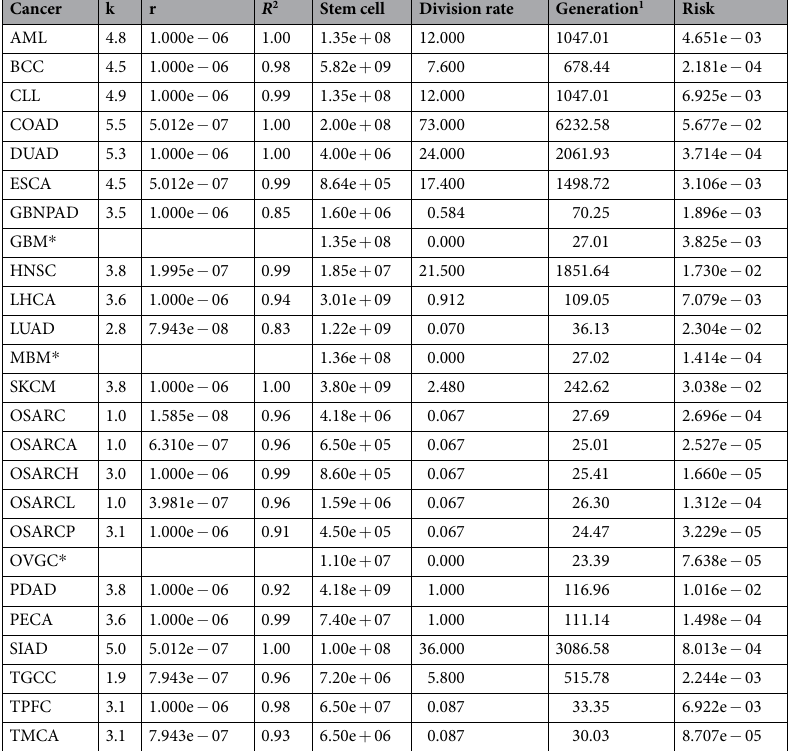
Table 1. One possible combination of parameters with which the tLIR model of 11 fits empirical data well. We are restricting r to be in the range [10 − 10 , 10 − 6 ] as was done by 11 . 1 Assuming lifetime is 85 years old, stem cells go through generations. * Cancers of which parameter estimates are impossible because division rate is 0.